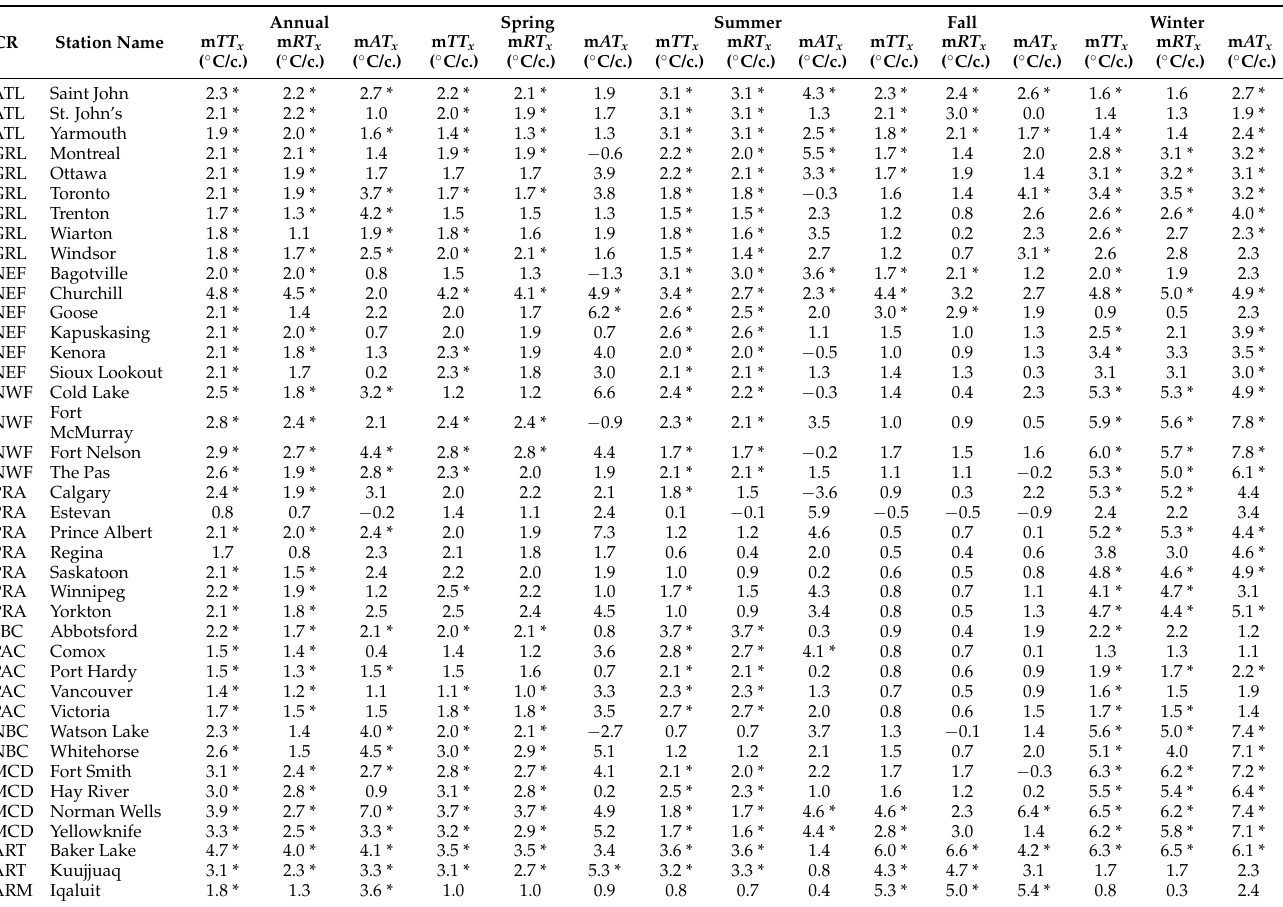
Table 6. Regional radiative population counts, radiative population participation, and radiative population slope of counts reported per century (#/c.) “m” represents “slope”. RPC—Radiative Pop- ulation Count, RPP—Radiative Population Participation, and m RP c —Slope of Radiative Population Count. “CR” represents “climate region”. ATL—Atlantic Canada, GRL—Great Lakes/St. Lawrence Lowlands, NEF—Northeastern Forest, NWF—Northwestern Forest, PRA—Prairies,